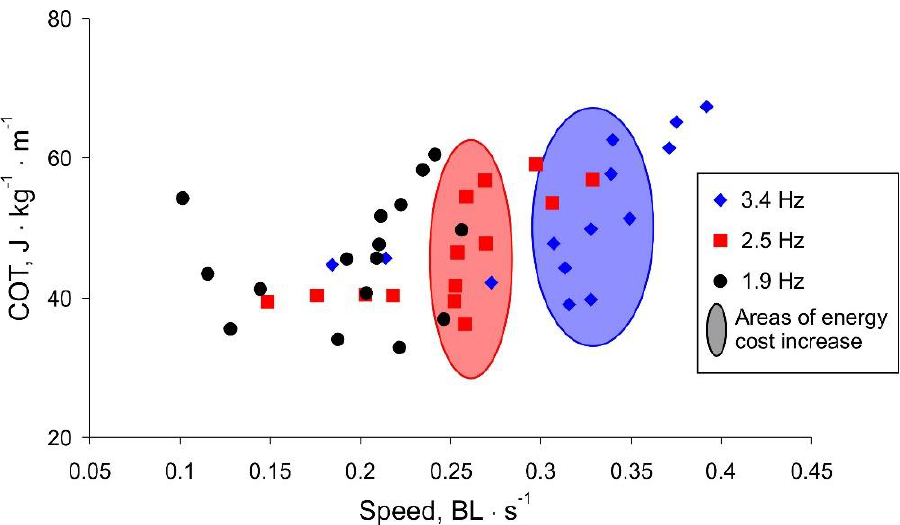
Figure 8. Summary characteristic of the robot movement. Marked areas illustrate a threshold speed above which the increase of movement speed is energetically expensive.